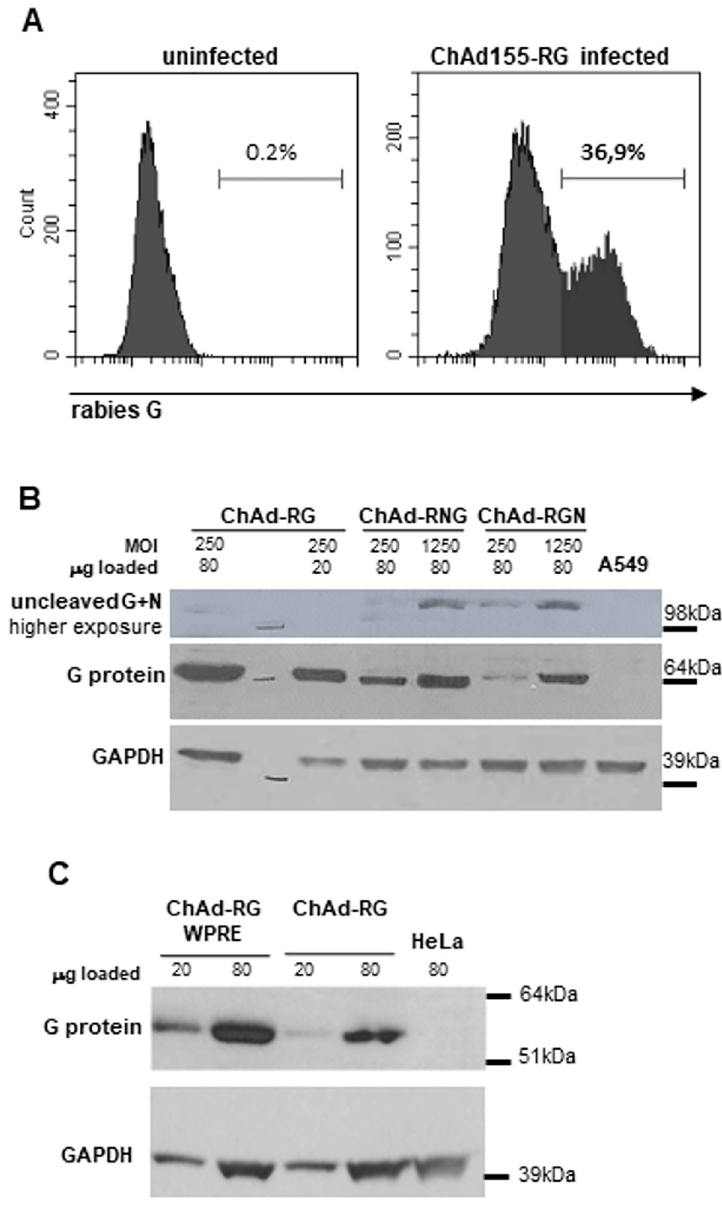
Fig 1. Rabies antigens expression in ChAd155 vectors. A) Whole cell FACS analysis of MRC5 cells not infected (left panel) and infected with 50 MOI (vp/cell) of ChAd155-RG (right panel). 48h after infection cells were stained with anti-Rabies Glycoprotein antibody and FITC-conjugated anti-mouse secondary antibody. B) Western blot analysis of G protein on lysates of A549 cells infected with 250 MOI of ChAd155-RG and 250 and 1250 MOI of ChAd155-RNG and ChAd155-RGN. 48h after infection cells were harvested and 20 μ g and 80 μ g of total cell lysates were used for WB analysis. GAPDH was used as a loading control. C) Effect of WPRE on G protein expression. Western blot analysis of G protein on total cell lysates. HeLa cells were infected with 250 MOI of ChAd155-RG +/- WPRE, 48h after infection cells were harvested and 20 μ g and 80 μ g of total cell lysates were analyzed by WB. GAPDH was used as a loading